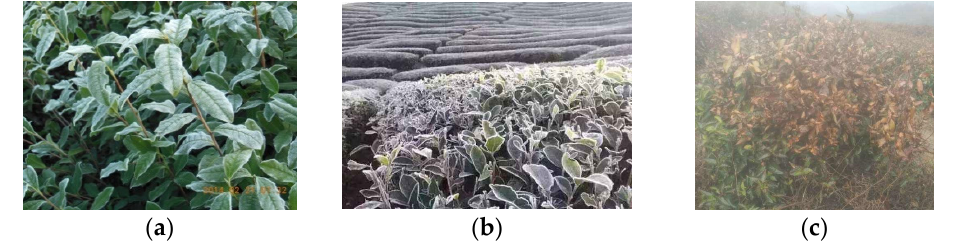
Figure 2. Symptoms of frost damage on tea plants: ( a ) light frost damage; ( b ) medium frost damage; ( c ) heavy frost damage.